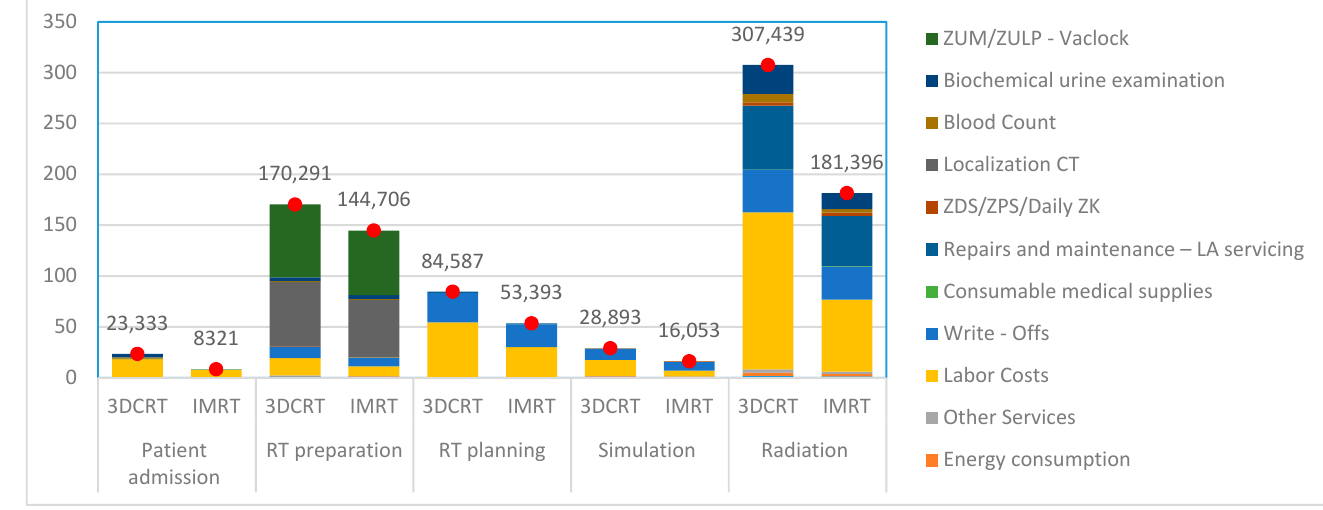
Figure 3. Comparison of costs of component treatment process activities for both modalities. Red dots represent the total.